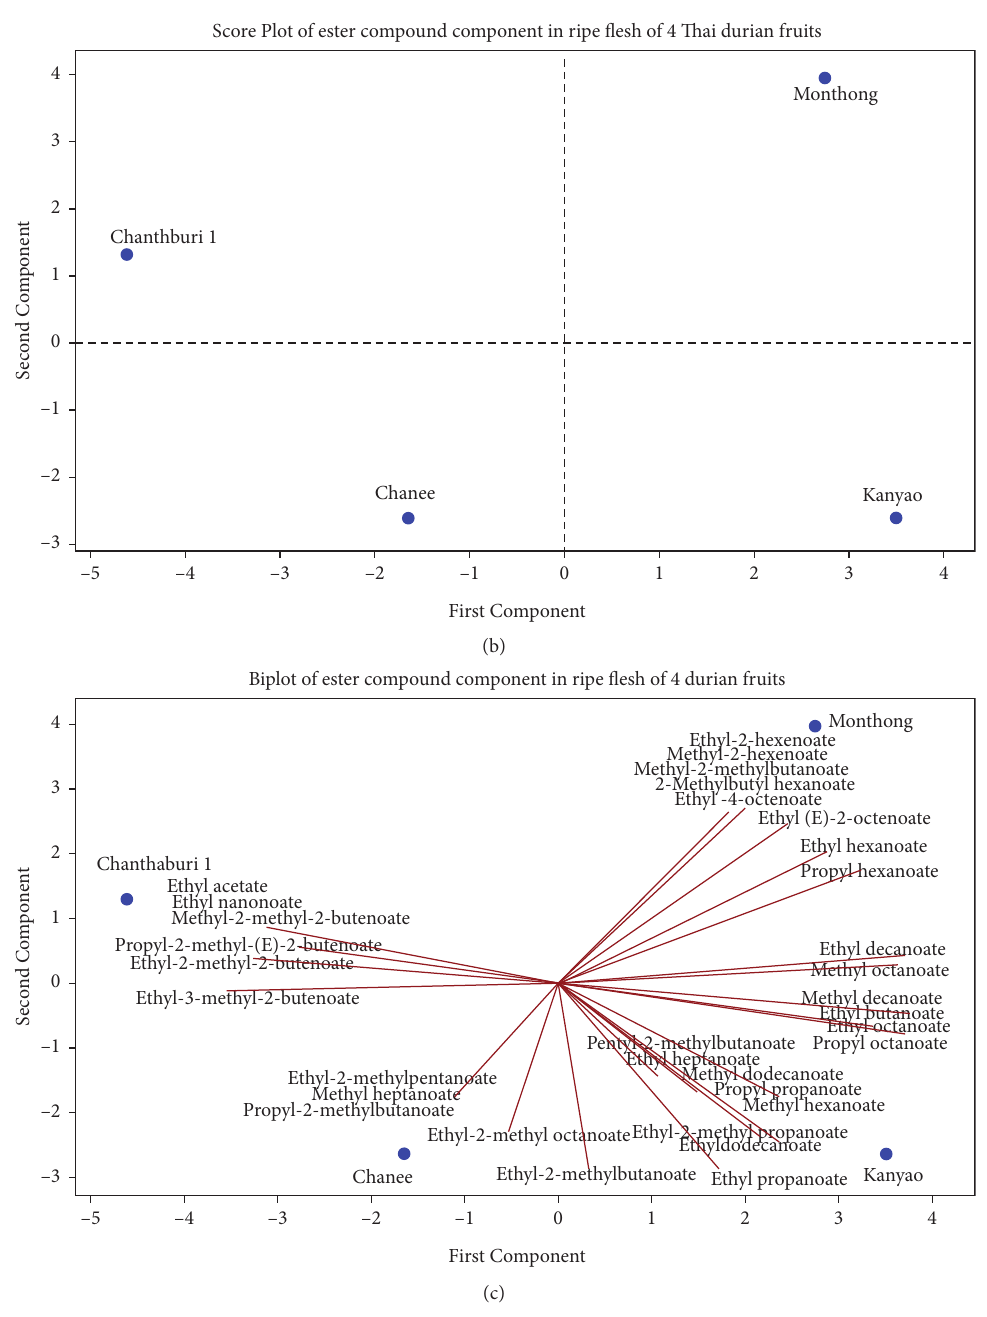
Figure 3: Principal component analysis (PCA) relationship between 4 Thai durian cultivars. (a) Score plot of the relationship between 4 Thai durian cultivars using the ester compounds. (b) Score plot of the ester compound component in ripe flesh of 4 Thai durian cultivars. (c) Biplot of the ester compound component relationship with 4 Thai durian